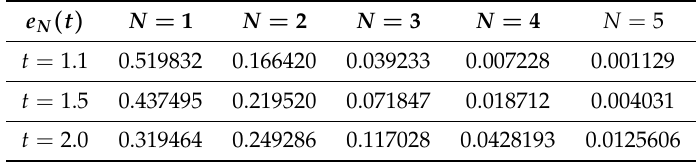
( x , t ) , of the truncated solution SP, X N ( t ) , to the random IVP (27) taking as Figure 3. Left : 1-PDF, f N 1 the order of truncation N ∈ { 1,2,3,4,5 } and the corresponding 1-PDF, f 1 ( x , t ) , of the exact solution ( x ,2 ) , with N = 5, is plotted together with f SP at t = 2. Right : To facilitate the comparison, f N 1 Example 1. Table 1. Error measure e N ( t ) defined by (32) for different time instants, t ∈ { 1.1,1.5,2 } , and orders of truncation of the approximate solution SP, N ∈ { 1,2,3,4,5 } . Example